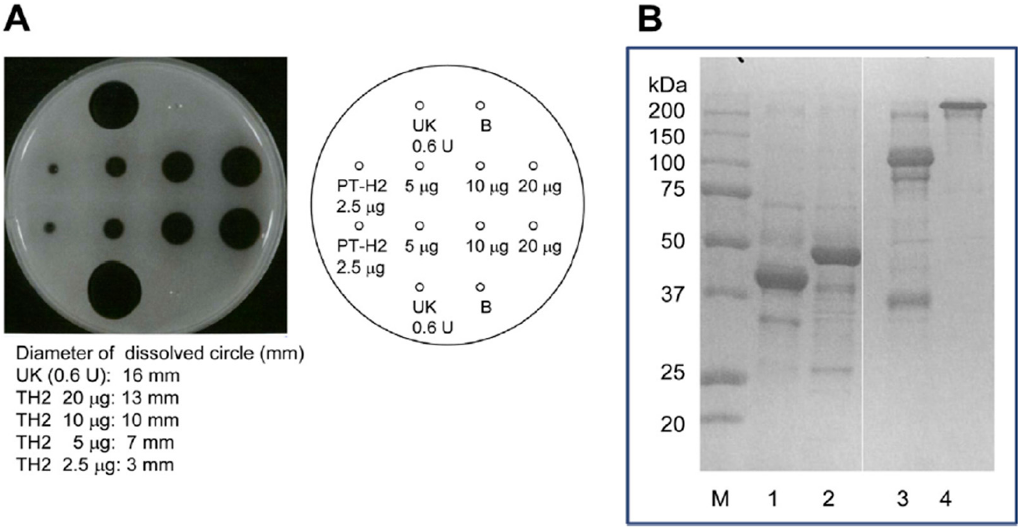
Figure 4. Effect of PT-H 2 on bovine fibrin plates and SDS-PAGE of solutions that had been dissolved using PT-H 2 or urokinase. ( A ) Fibrinolytic activity of PT-H 2 and urokinase (as a positive control); ( B ) SDS-PAGE (Laemmli, 10% gel, Coomassie Brilliant Blue staining) of solutions that had been dissolved using PT-H 2 (lane 2: reducing conditions, lane 4: non-reducing conditions) or urokinase (lane 1: reducing conditions, lane 3: non-reducing conditions). The assay of fibrinolytic activity was measured using the fibrin plate. A fibrin plate was prepared by the following methods. Bovine fibrinogen solution (16 mL, 10 mg/mL) in 0.02 M Tris-HCl buffer (pH 7.5) containing 0.15 M NaCl and 5 mM CaCl 2 was poured in a plate (internal diameter: 94 mm). Then thrombin solution (100 μ L, 100 units/mL) was added to the plate, and clotted at 30 °C for 2 h. Sample solution containing the protein applied to the well, and incubated at 25 °C overnight. After incubation, the fibrin plate was washed with saline three times, and then circle diameters dissolved by fibrinolytic enzyme and by urokinase as positive control were measured, respectively. Fluid from each circle dissolved by PT-H 2 protease or urokinase was sampled and then subjected to SDS-PAGE.